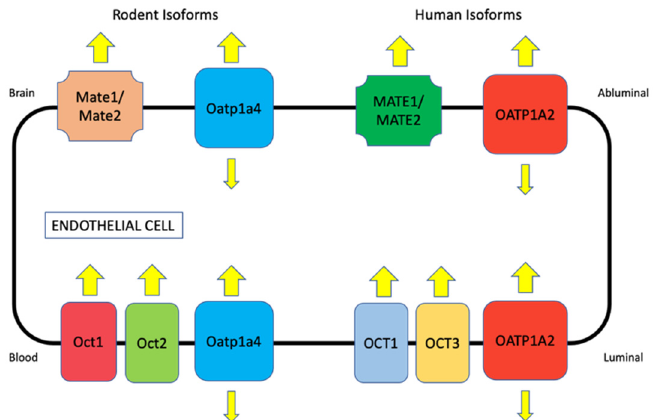
Figure 2. Localization of SLC Transporters in Brain Microvessel Endothelial Cells. Adapted with permission from Nilles et al. ref. [17]. Copyright 2022 by the